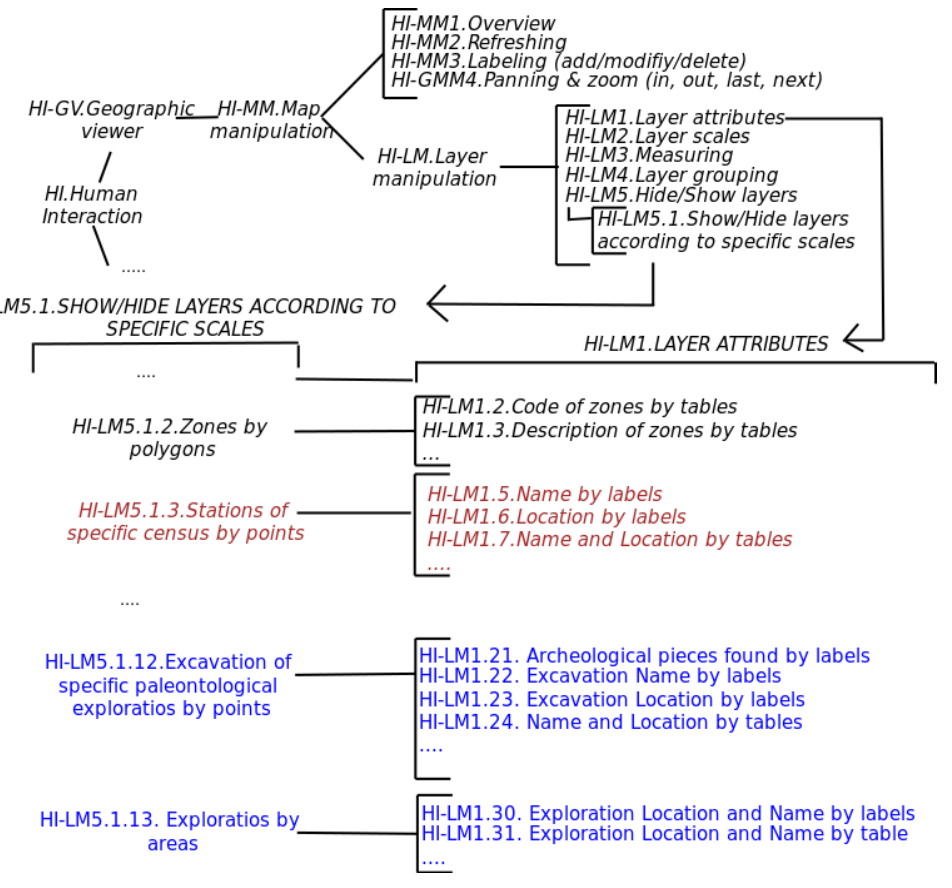
Figure 11. Relocated services in the Human interaction